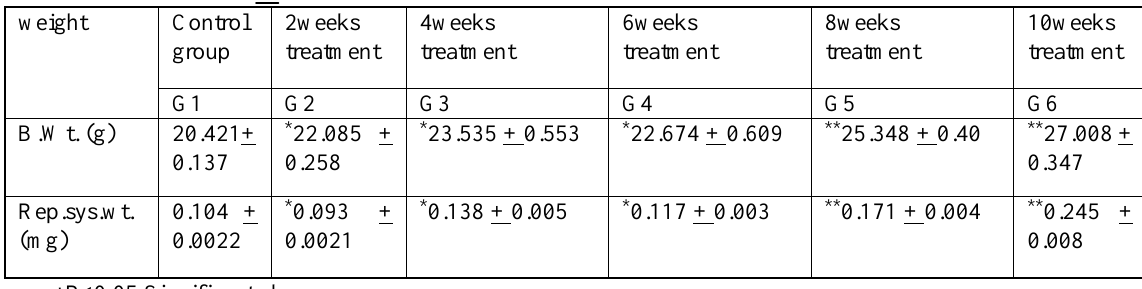
Table (1): Changes in the body weight gm and reproductive system weight mg after oral administration of pentoxifylline to mature female mice x = S.E. n= (n =10)